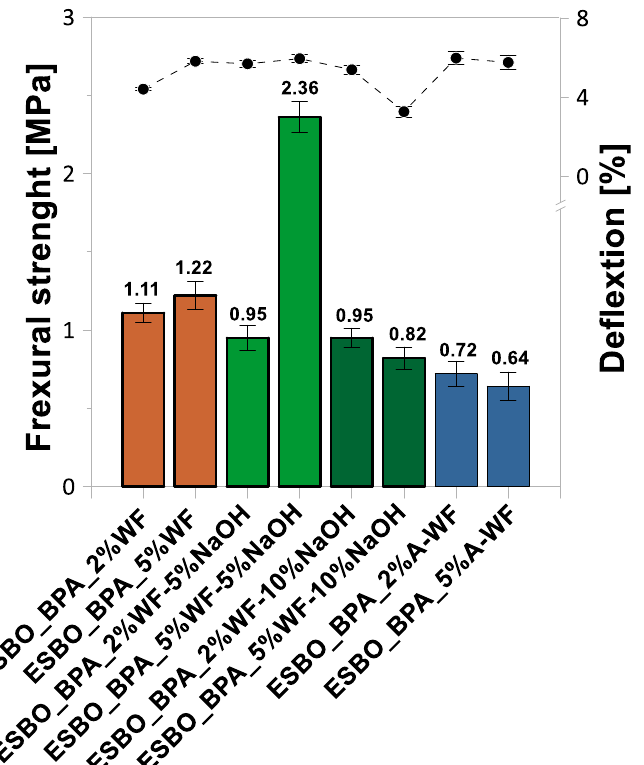
Figure 5. Tensile strength and elongation at break of compositions based on ESBO_BPA filled with waste oak flour.